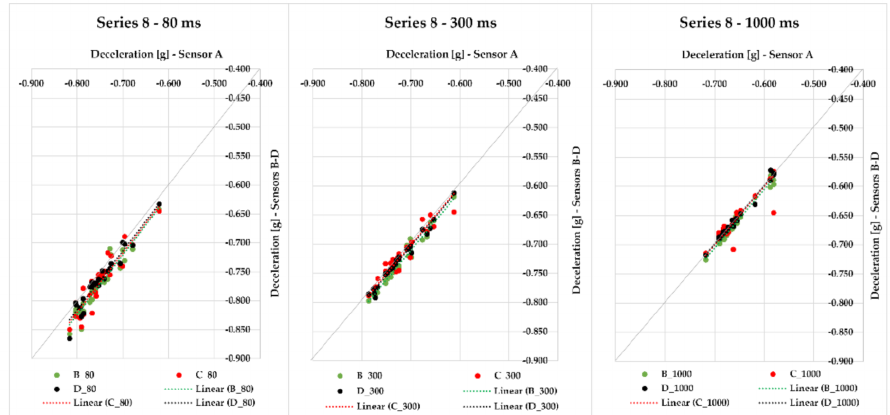
Figure 14. Series 8-Point dependency of individual MEMS sensors against sensor